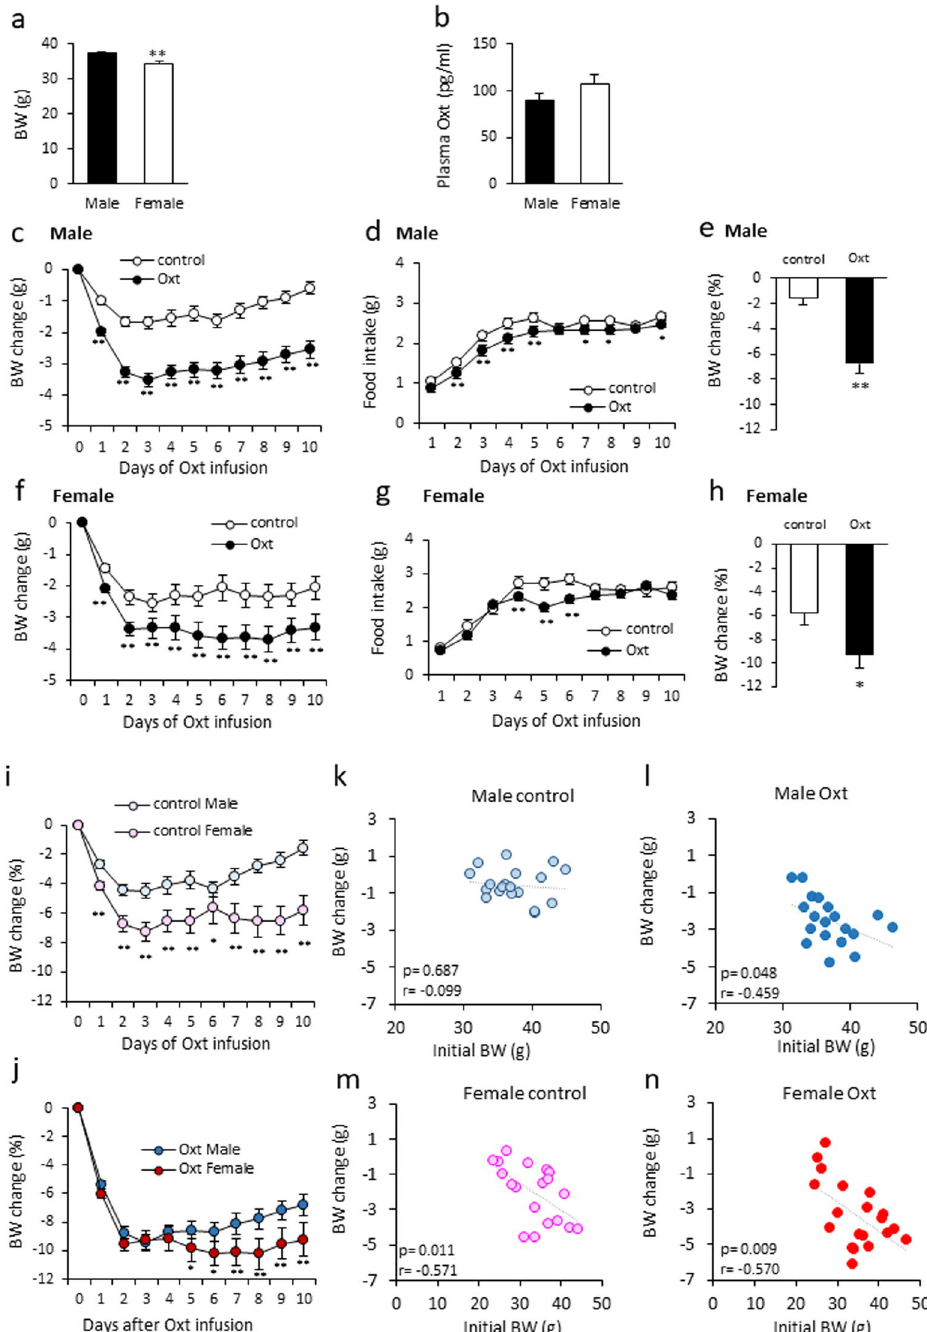
Figure 1. The effect of Oxt treatment on BW and food intake in male and female mice fed a high-fat diet. ( a ) Initial body weight of males and females used in this study. ( b ) Plasma Oxt levels in HFD-fed male and female mice (n = 8, 7). ( c , d ) Daily BW change ( c ) and food intake ( d ) during the Oxt infusion period in HFD-fed male mice. (n = 19, 19) ( e ) The percentage of BW change at 10 days after starting Oxt infusion in male mice. ** P < 0.01 by unpaired Student’s t -test. ( f,g ) Daily BW change ( f ) and food intake ( g ) during the Oxt infusion in HFD-fed female mice. (n = 19, 20) * P < 0.05, ** P < 0.01 by two-way ANOVA followed by Tukey’s multiple range test. ( h ) The percentage of BW change at 10 days after starting Oxt infusion in female mice. * P < 0.05 by unpaired Student’s t -test. ( i ) The percentage of BW change during 10 days in control male and female. * P < 0.05, ** P < 0.01 by two-way ANOVA followed by Tukey’s multiple range test. ( j ) The percentage of BW change during 10 days in Oxt treated male and female. * P < 0.05, ** P < 0.01 by two-way ANOVA followed by Tukey’s multiple range test. ( k,l )The correlation of BW change at 10 days and initial BW (BW at day 0) in control ( k ) and Oxt-treated ( l ) male mice. ( m , n ) The correlation of BW change at 10 days and initial BW (BW at day 0) in control ( m ) and Oxt-treated ( n ) female